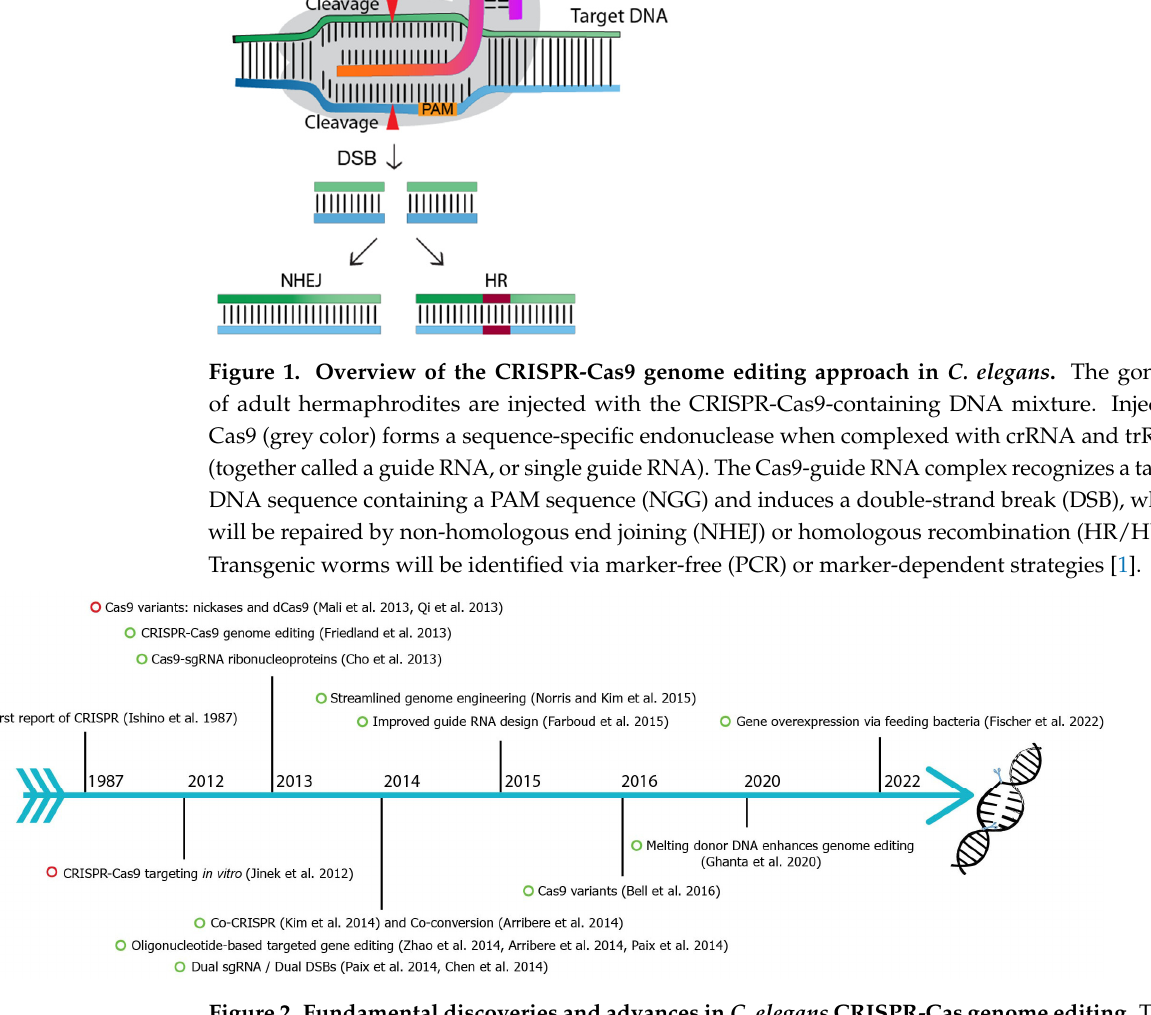
Figure 2. Fundamental discoveries and advances in C. elegans CRISPR-Cas genome editing. Time- line highlighting major events of C. elegans CRISPR-Cas9 (green circle) and other species (red circle). CRISPR were first identified in E. coli in 1987 [2–21].